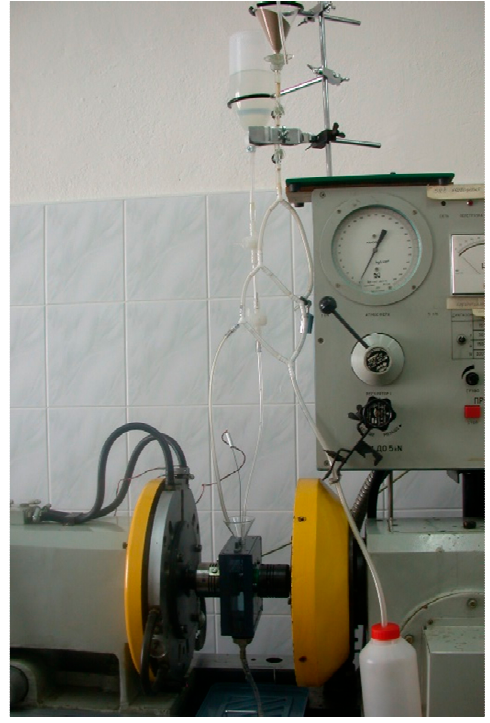
Figure 5. A view of the material supply system.